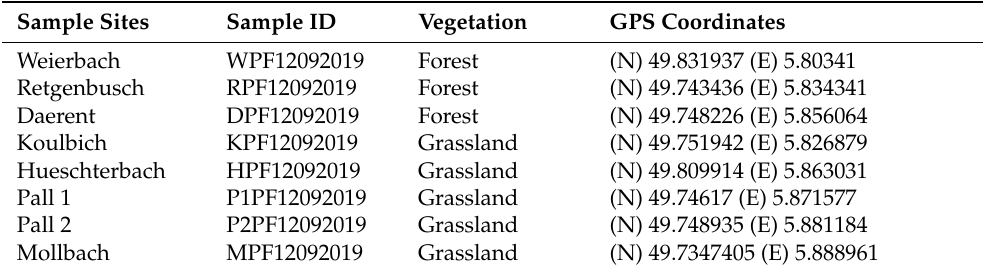
Figure 1. Map of the Attert River basin with the location of the eight sampling sites (modified from Geoportail.lu). Brown colours: forest sites; green colours: grasslands. With an oversimplified scheme, the plain black line represents the border between the Luxembourg and Belgian sides of the basin while the dashed red line is the limit between Oesling and Gutland regions. The Attert River is highlighted in pink, the affluents of the Attert River are in blue and the affluents of affluents, in orange. Table 1. List of the samples with their GPS coordinates.